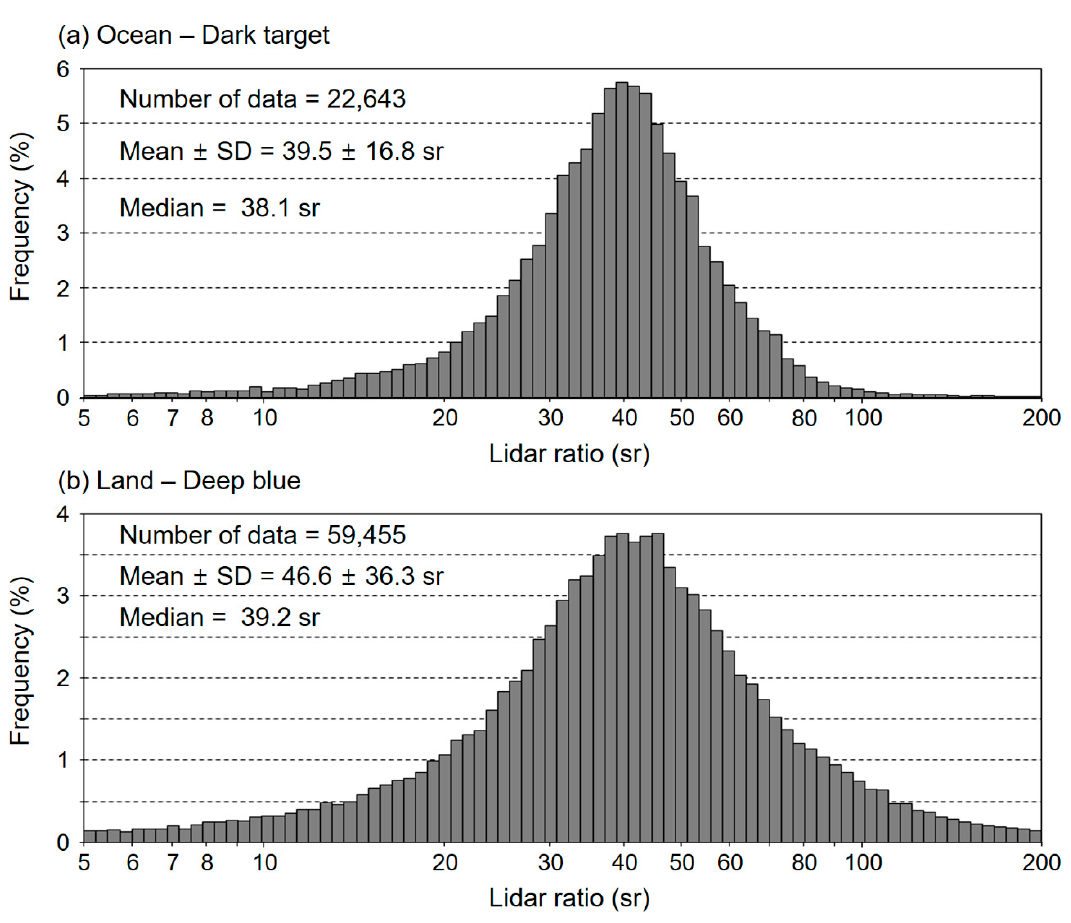
Figure 4. Frequency distribution of the retrieved dust lidar ratios ( a ) over ocean using MODIS DT AOD as a constraint and ( b ) over land using MODIS DB AOD as a constraint from 2007 to 2011. Note that the x -scale is logarithmic. Tails for both ends (lower than 5 sr and higher than 200 sr) are omitted in the figure but included for the statistics.